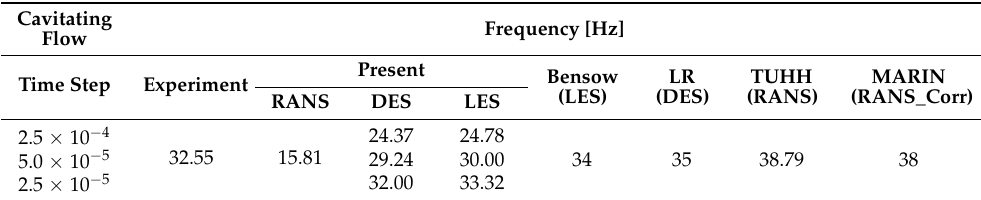
Table 5. Shedding frequency according to the time steps and turbulence models (RANS, DES, LES) and another numerical